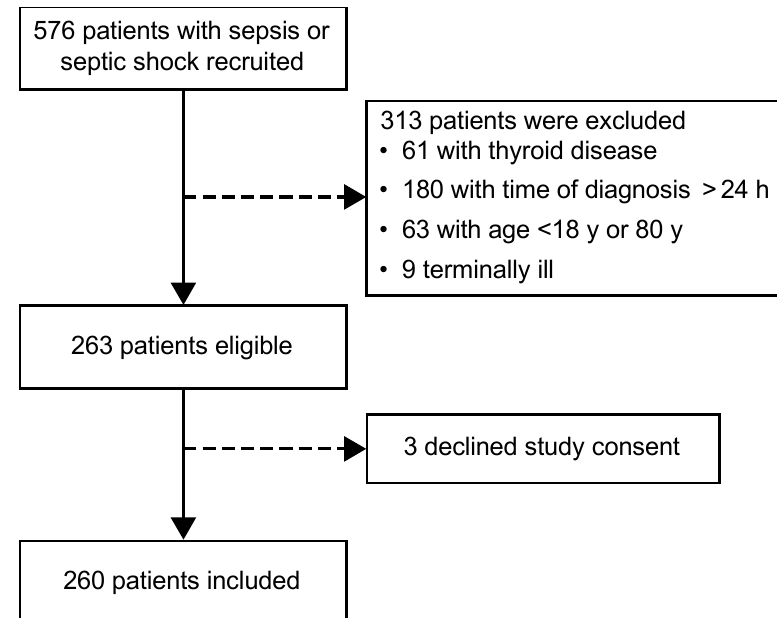
Figure 4. Flowchart showing patient selection.